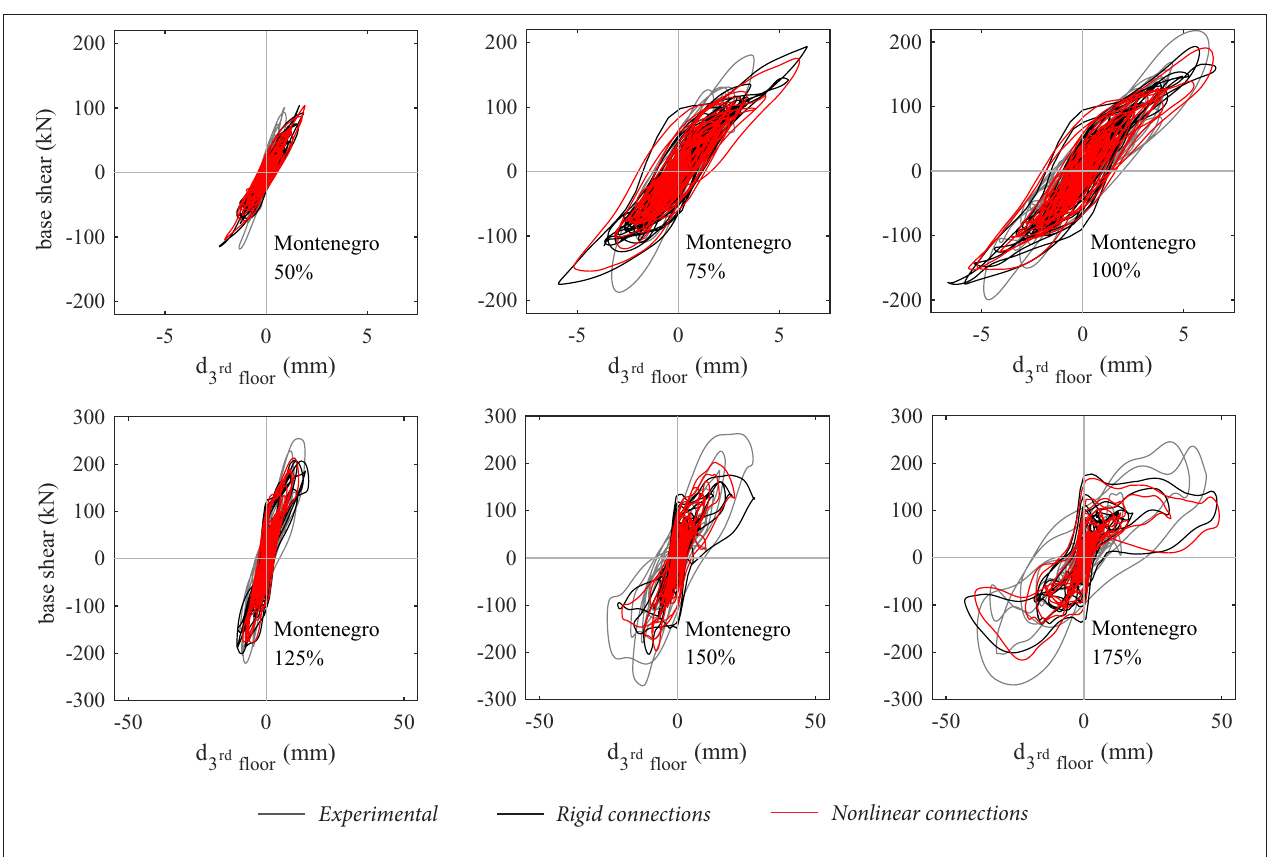
FIGURE 7 | Stone masonry building: comparison between experimental and numerical force-displacement global